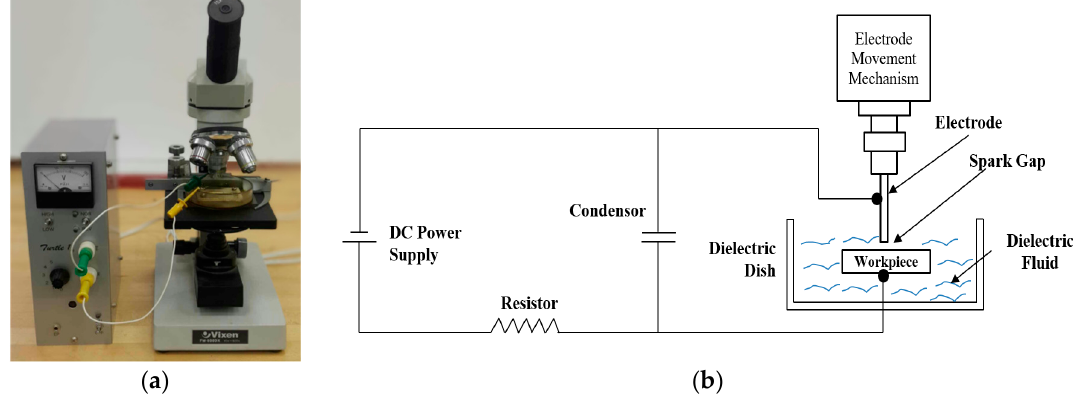
Figure 1. ( a ) Tabletop type micro-electric discharge machining (micro-EDM) used in the investigation; ( b ) resistor capacitor (RC) circuit of the power source.